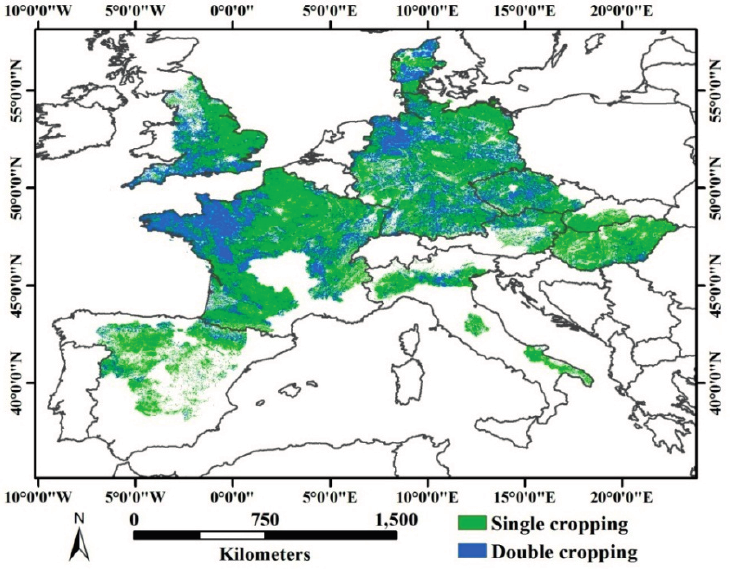
Figure 9. Cropping intensity map for Western Europe in